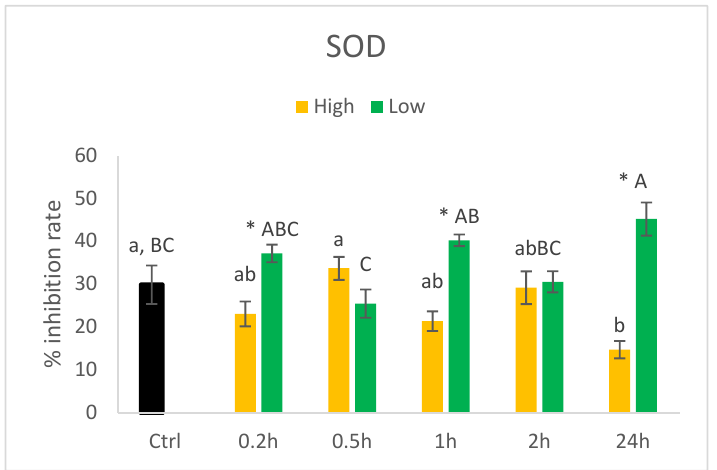
Figure 10. Activity (%inhibition rate) of SOD in HT29 cells exposed to high (140 µM) or low (0.014 µM) concentrations of HHE. Data (n = 4) are means shown with standard error mean. Significant differences between control (Ctrl) and different time points within Low or High groups are indicated with different letters (High: lower letters, Low: capitalised letters) evaluated with Tukey–HSD ( p < 0.05). Significant differences between Low and High are evaluated by Student’s t -test and indicated with asterisk (*) at specific time points.